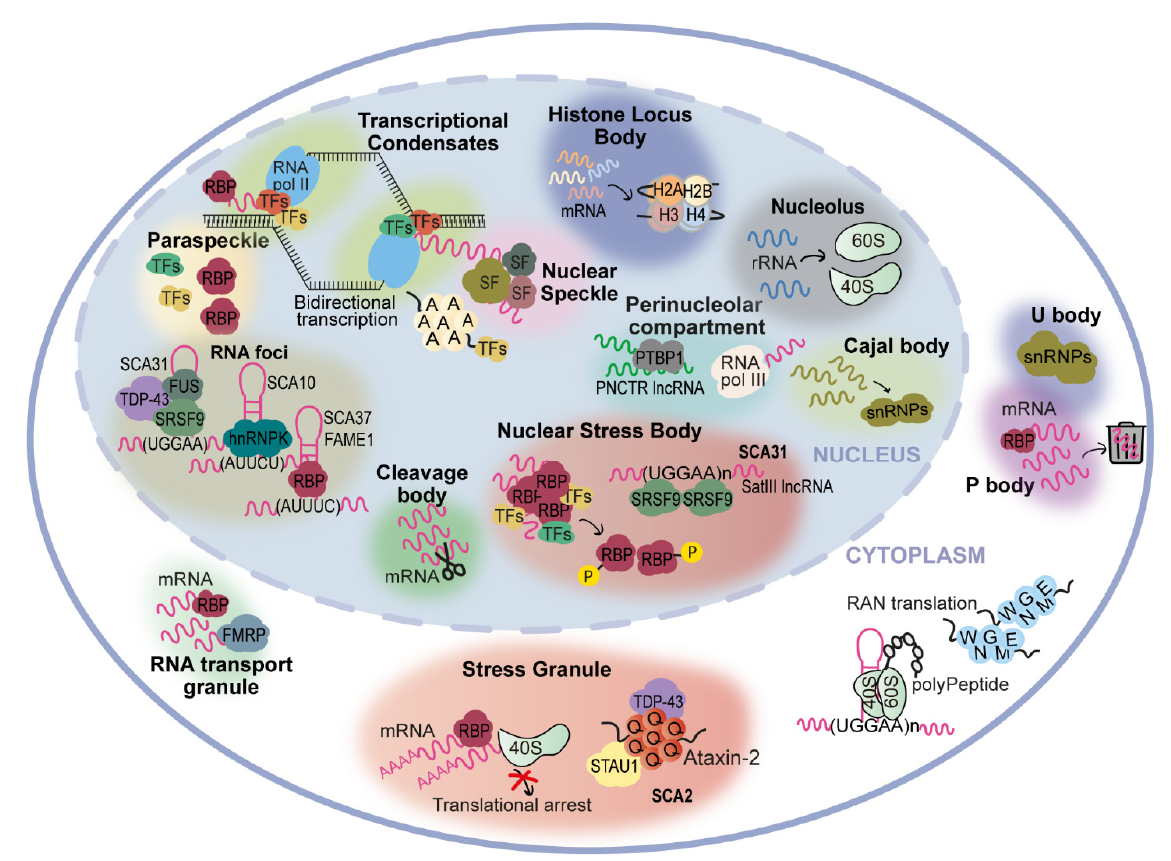
Figure 2. Representation of cellular condensates and location of RNA and proteins with expansions. Transcriptional condensates, formed by liquid–liquid phase separation, concentrate TFs, mediators, and other crucial players in transcription initiation. They are closely located to nuclear speckles, small reservoirs of splicing factors acting in mRNA splicing, and to paraspeckles, that assemble TFs and RBPs, thus regulating gene expression. Histone loci bodies drive histone synthesis and storage [71], while RNA transport granules carry mRNAs from and to the nucleus. The nucleolus is (1) in nuclear stress bodies, the phosphorylation of RBPs leads to alterations in mRNA splicing of their target genes; in SCA31, the toxic (UGGAA) n competes with SatIII (UGGAA) n non-coding RNA for SRSF9 binding; (2) in the cytoplasm, the stress granules sequester mRNA, arresting translational initiation; Ataxin-2 protein has been implicated in the assembly of stress granules when expanded interacts with TDP-43 and recruits Staufen1 (STAU1) protein, leading to alterations in stress granule dynamics [4]. Perinucleolar compartment is thought to be the place where RNA Pol III transcripts are processed; additionally, recent work has demonstrated that the recruitment of PTBP1 by PNCTR long non-coding RNA controls the splicing patterns of RNA Pol II transcripts [72]; cleavage bodies are regions of mRNA processing. P bodies stall untranslated mRNAs, mediating its decay. U bodies assemble and store small nuclear ribonucleoproteins (snRNPs), previously biosynthesized in Cajal bodies. There are several mechanisms contributing to pathology in repeat expansion diseases (e.g., bidirectional transcription, RNA foci formation and RAN translation; most of them disturb phase-separation capacity, interfering with the correct assembly of condensates. Polyalanine—polyA;